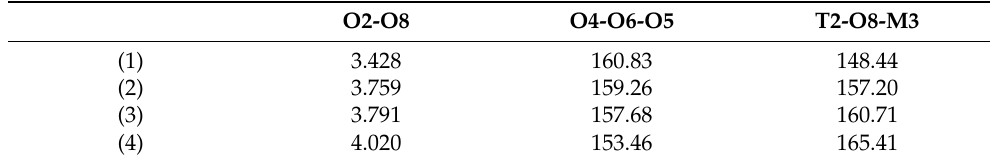
Figure 8. Progressive substitution of Ca 2+ with A 2+ cations within A1 and A2 cavities causes an increase of their size. The progressive decrease of O4-O6-O5 angle is linked to the entering of A 2+ in A1 cavity, whereas the increase of O2-O8 distance and of T2-O8-M3 angle highlights the entering of A 2+ in A2 cavity. Table 12. Selected interatomic bonds (Å) and angles ( ◦ ) in (1) Zoisite [36]; (2) zoisite-(Pb) (this study); (3) synthetic Sr-zoisite [5]; (4) synthetic Pb-zoisite